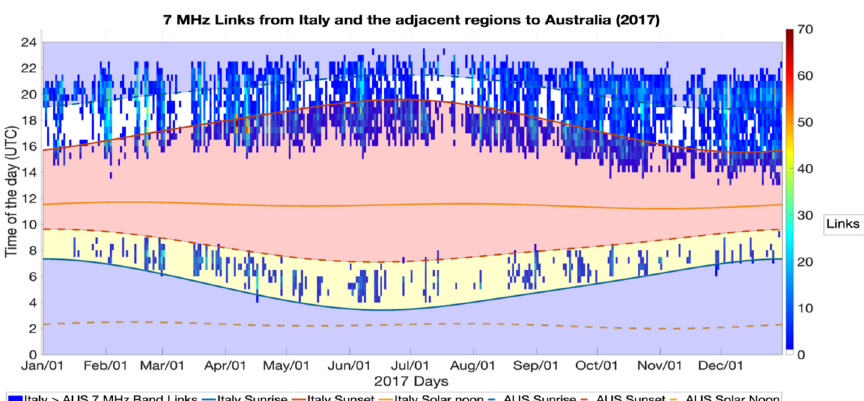
Figure 17. The 7 MHz radio links made from the Italy and the adjacent regions to Eastern Australia in 2017. The blue shaded area is the Australian daytime hours. The red area is the UK daytime hours. The yellow shaded area is the common daytime hours, and the white shaded area is the common night hours. The colours indicate the number of links available in each half-hour interval.